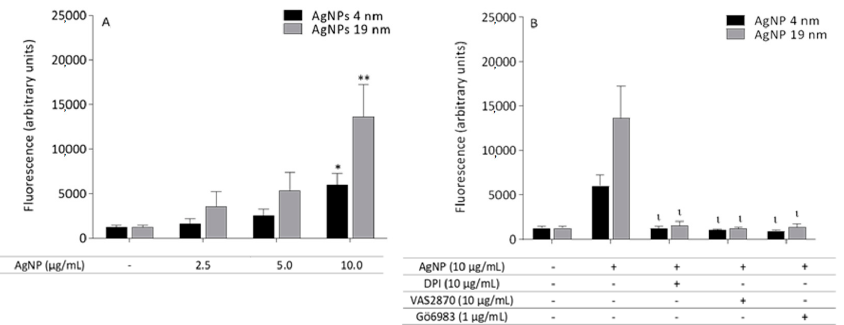
Figure 13. Effect of AgNP on neutrophil oxidative burst. Human neutrophils were exposed to 4nm and 19 nm AgNP (30 min) and the oxidative burst was determined upon incubation with DHR ( A ). For the AgNP concentration inducing neutrophil oxidative burst (10 µ g/mL), PKC inhibitors were tested for effect prevention ( B ). * p < 0.05, ** p < 0.01, when compared with the untreated cells ( A ). ι p < 0.05, when compared with the cells treated with AgNP. Values are presented as the means ± SEM ( n ≥